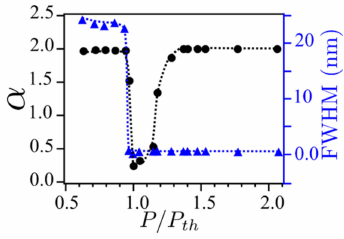
Figure 6. L é vy index α (circles) and FWHM (triangles) as a function of the normalized input pump power P / P th . Three statistical regimes of intensity fluctuations are observed: prelasing Gaussian with amplified spontaneous emission ( α = 2), L é vy-type RL (0 < α < 2) around the threshold, and Gaussian RL ( α = 2) well above the threshold. The sharp decrease in α at the first Gaussian-to-L é vy transition nicely coincides with the abrupt change in FWHM at the RL threshold. (Reproduced with permission from ref.